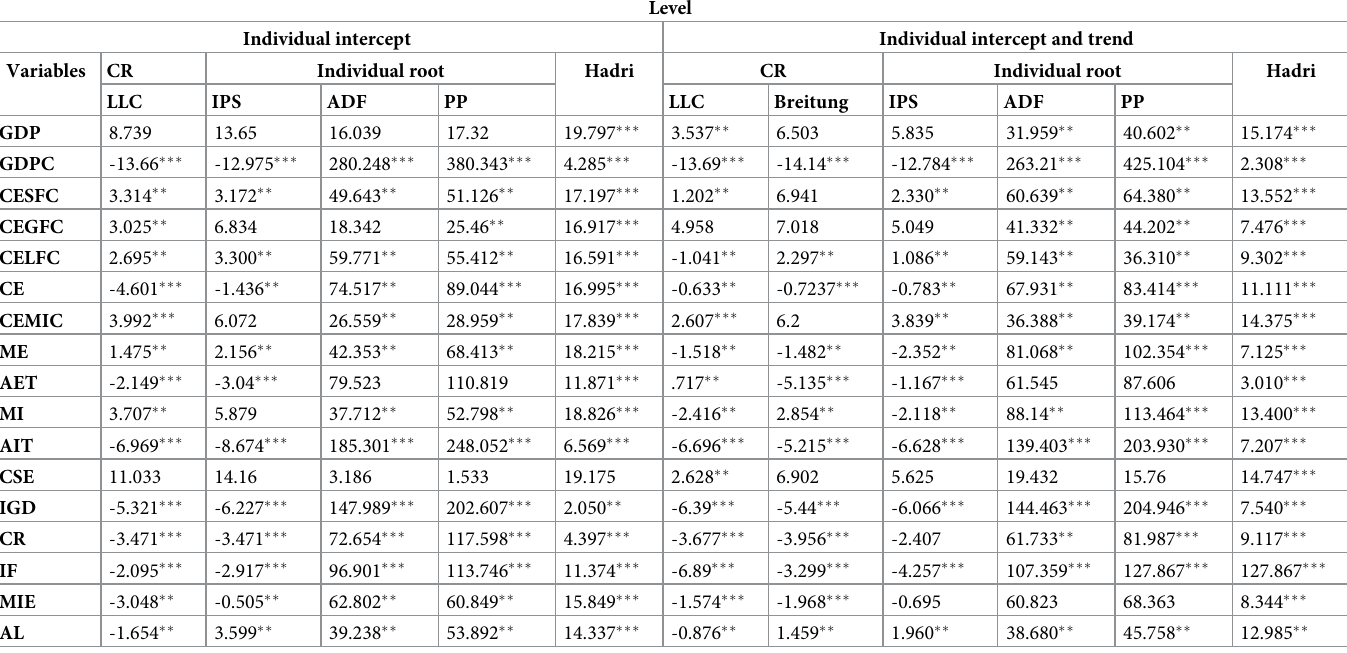
Table 7. Unit root of individual variables